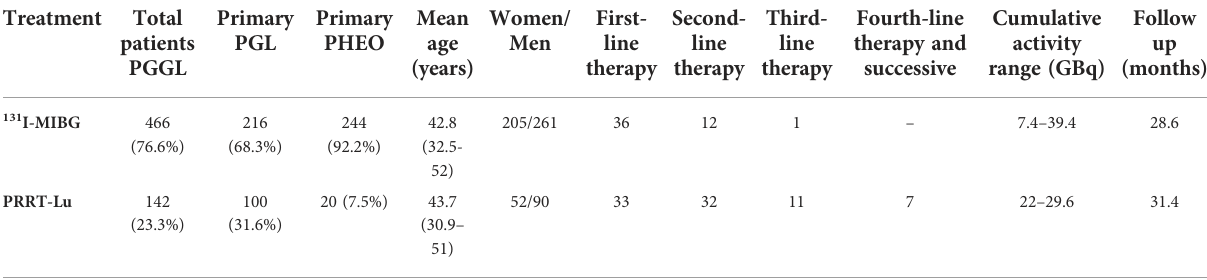
TABLE 3 Patient descriptive variables according to the treatment modality. In some variables, the data speci fi ed in the papers are scarce. Treatment